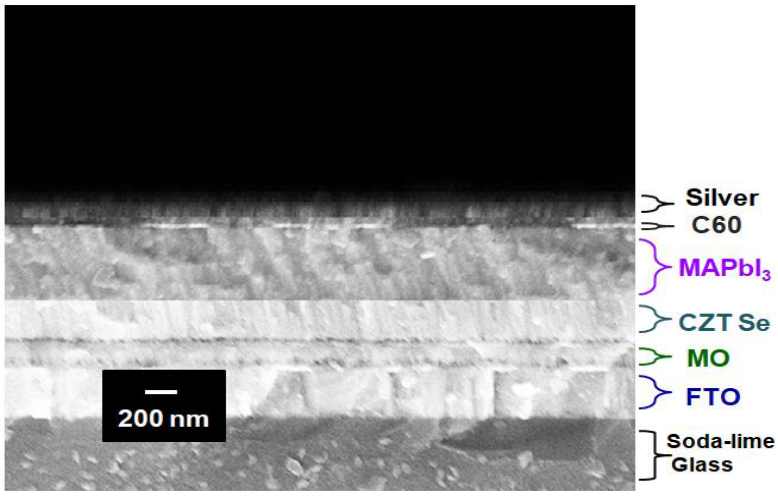
Figure 5. Cross-sectional SEM micrograph of Ag/C 60 /MAPbI 3 /CZTSe/Mo/FTO multilayered structures on glass substrate.